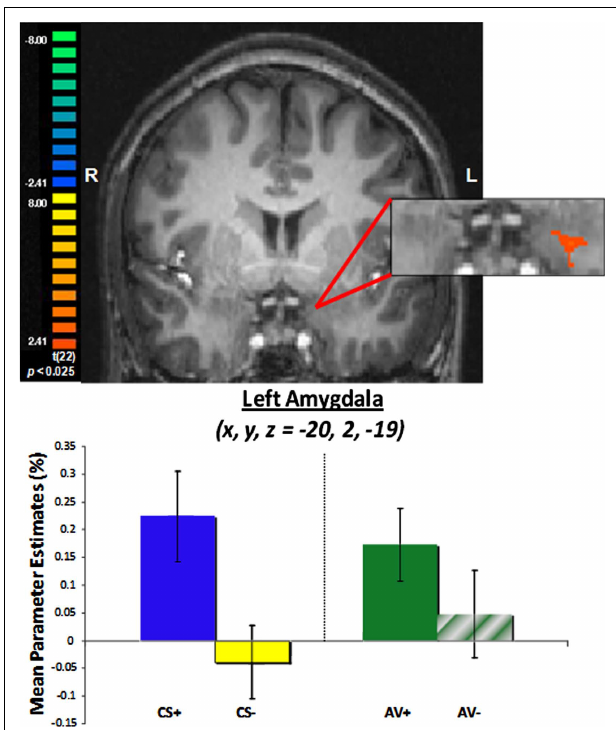
FIGURE 4 | Left amygdala ROI defi ned by a contrast of aversive (CS + and AV + ) and safe (CS − ) trials.